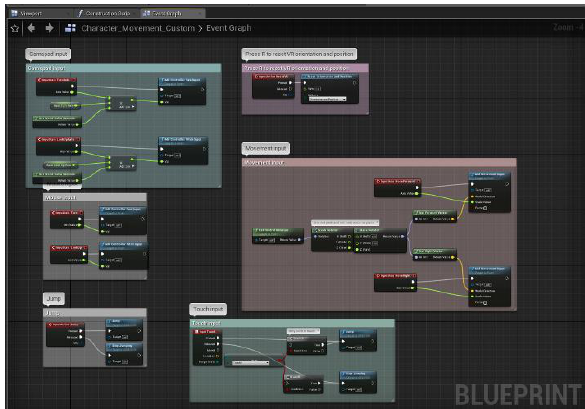
Figure 5. Setting the Unreal Engine 4 Blueprint Visual Scripting node